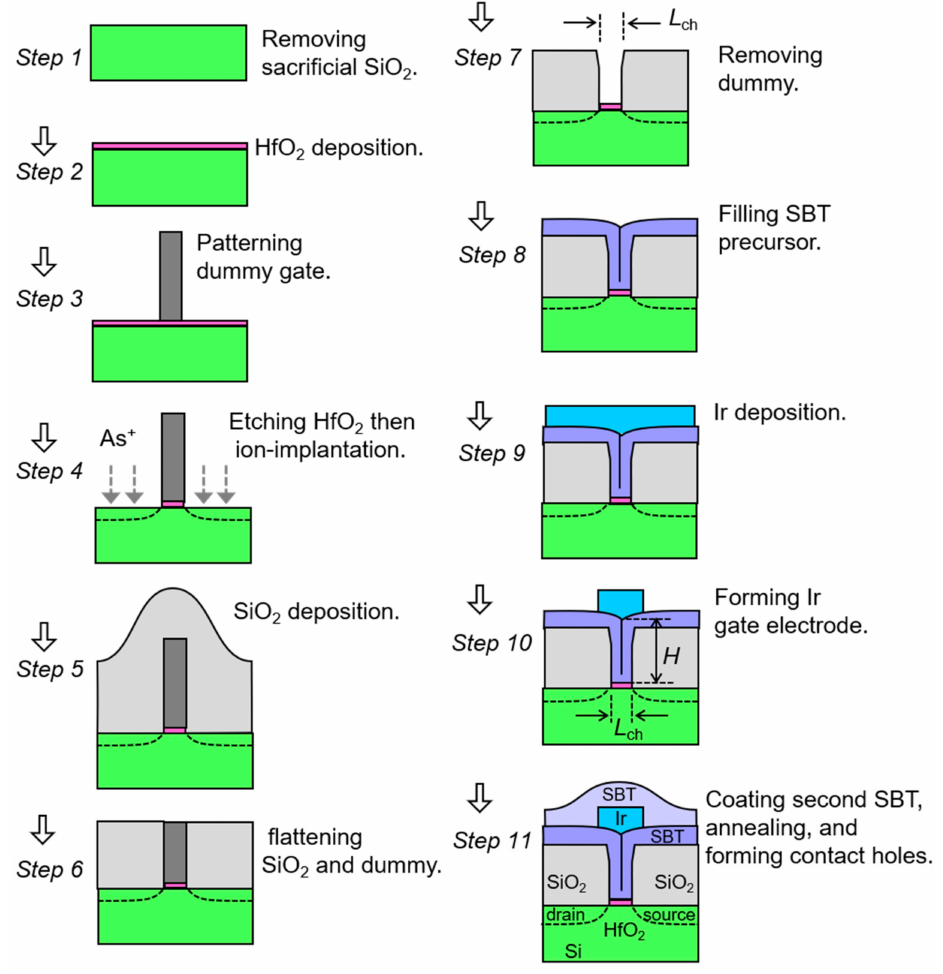
Figure 1. New fabrication process of Strontium bismuth tantalate (SBT)-ferroelectric-gate field-effect transistors (FeFETs) demonstrated in this